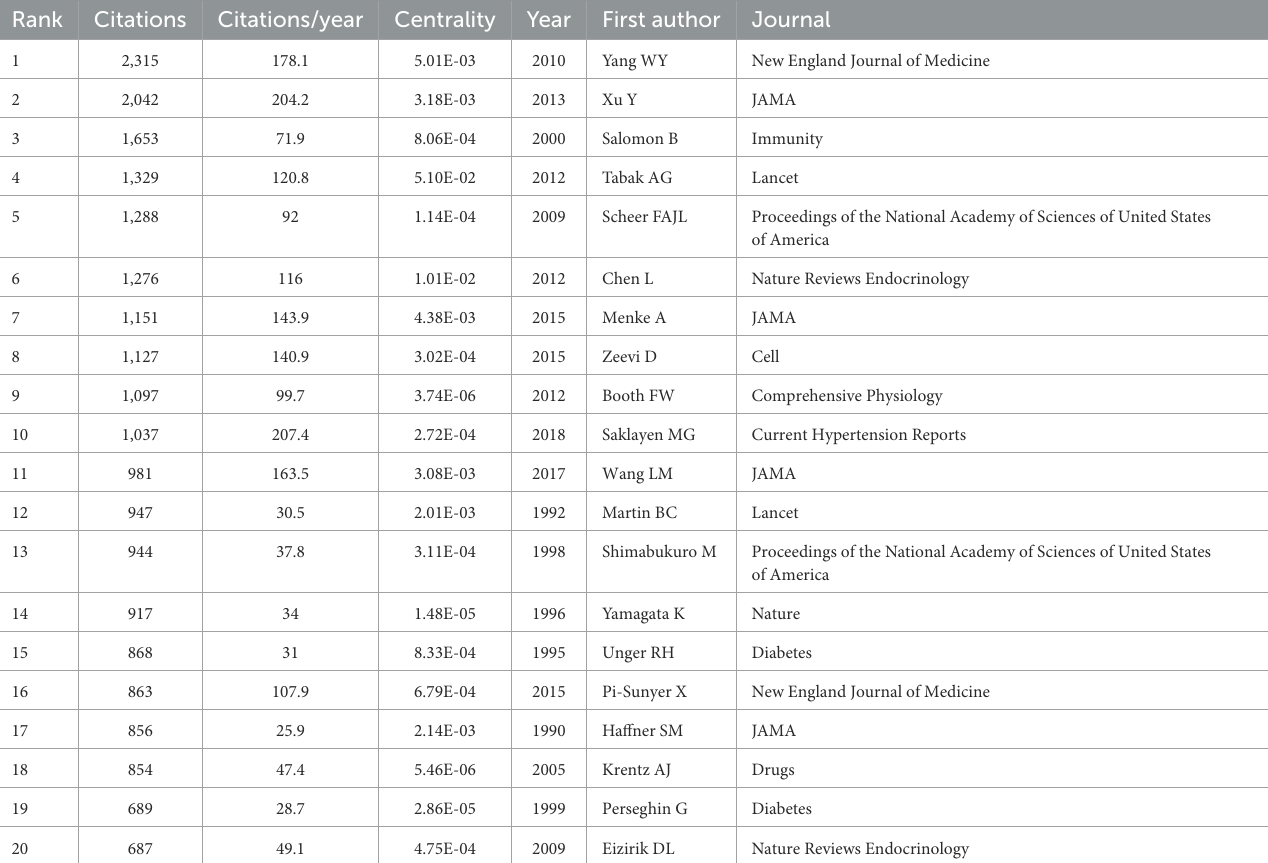
TABLE 2 Top 20 most highly cited articles of